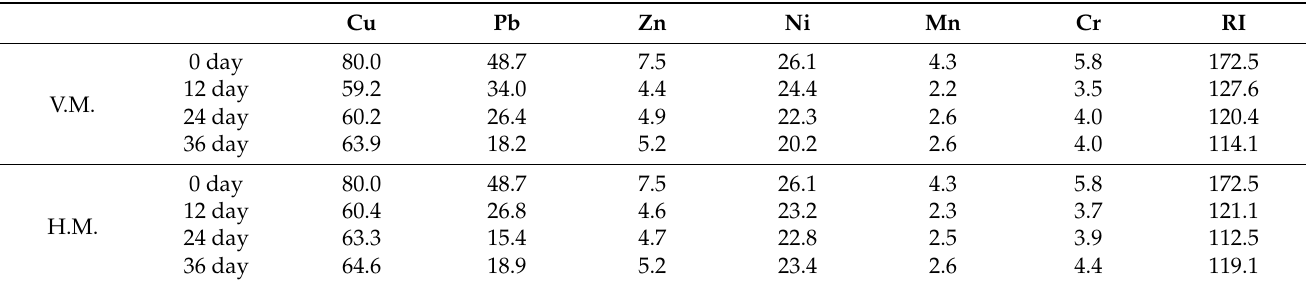
Figure 3. Concentrations of Cu ( A ), and Pb ( B ) in sediments. The error bars represent standard deviation (n = 5). The letters a, b, c and d denote significant differences between treatments, according to the LSD ( p < 0.05). Table 5. Risk assessment index